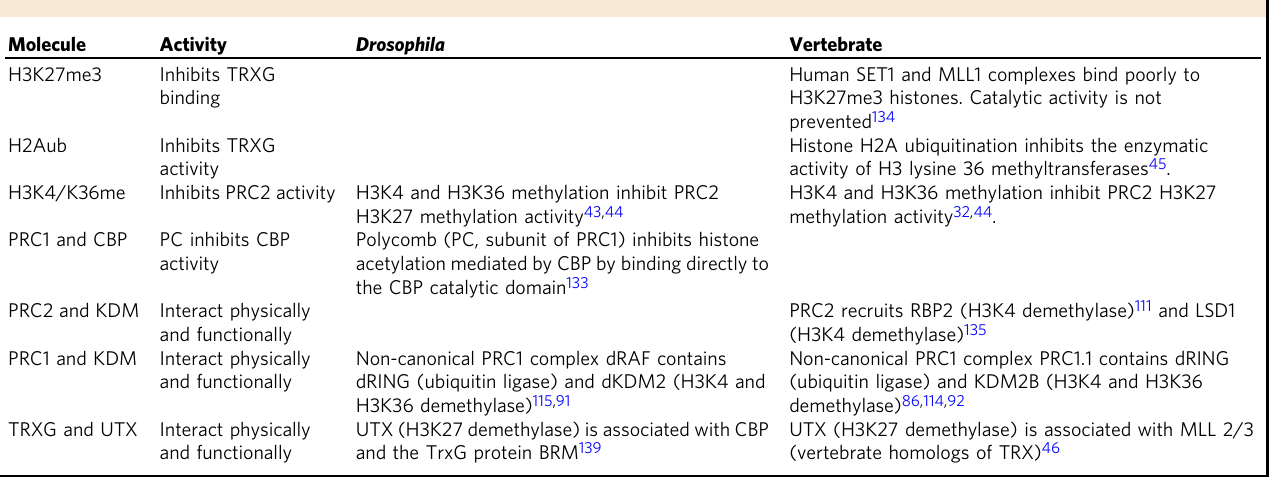
Table 3 Antagonistic interactions Molecule